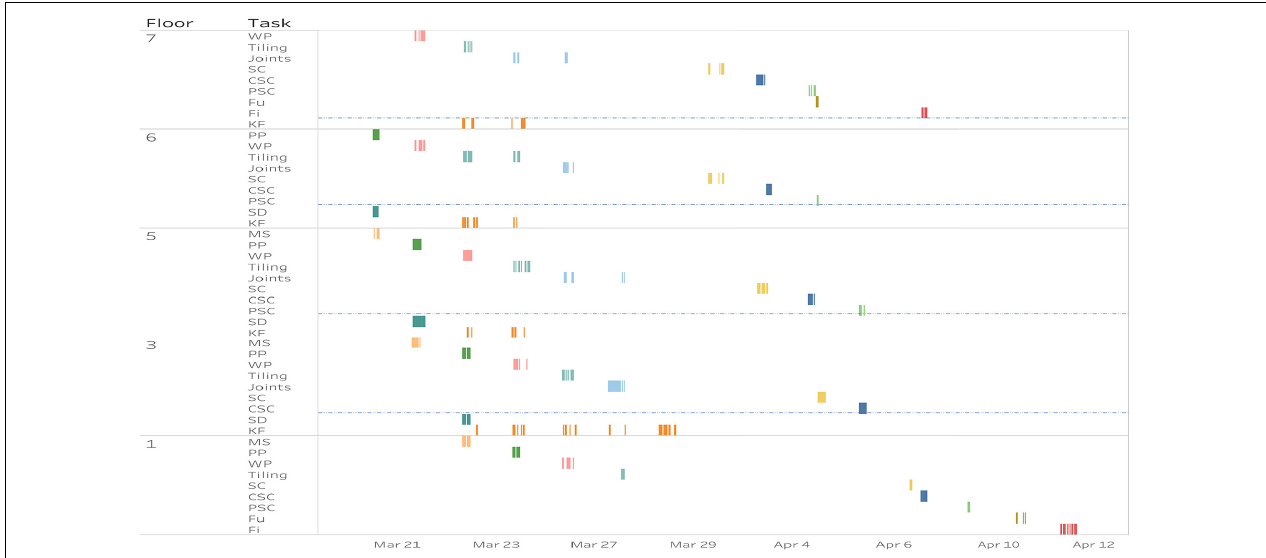
FIGURE 4 | Tracked tasks in all locations, excluding floor 4. Abbreviations: Masonry of shafts (MS); Preparation of concrete floor pours and pouring (PP); Waterproofing (WP); Suspended ceiling (SC); Caulking of suspended ceiling (CSC); Painting of suspended ceiling (PSC); Furnishing (Fu); Finishing (Fi); Shaft drywall; (SD); and Kitchen furnishing